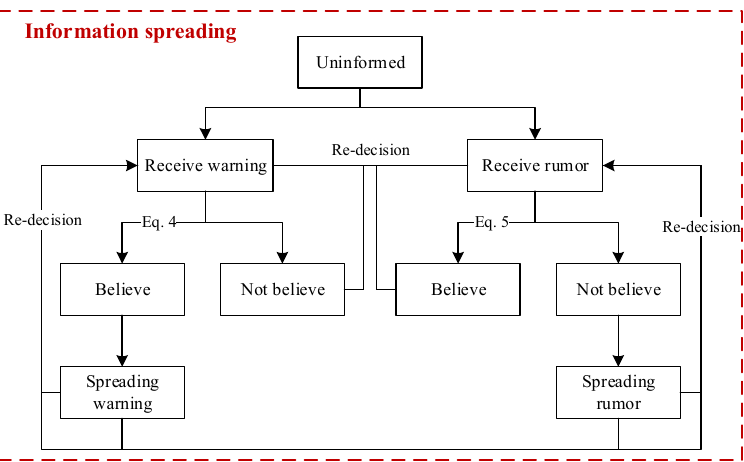
Figure 6. Flow chart of information spreading. The states of people will change when the transition conditions are met. Some transitions are described as equations.